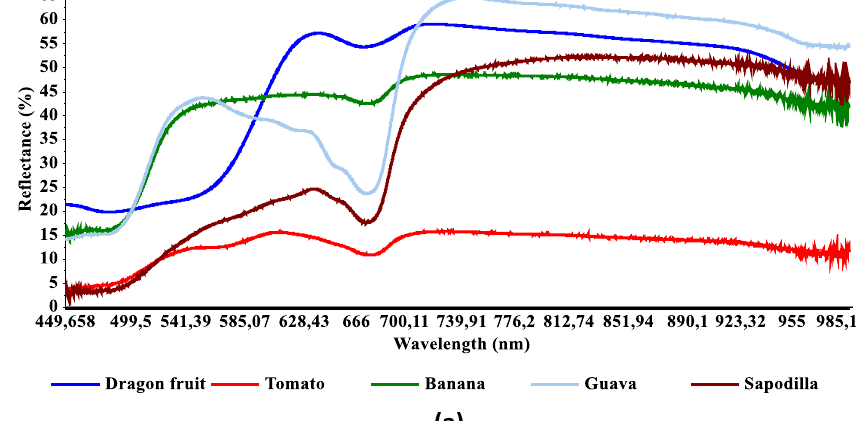
Figure 2 is re fl ectance spectra of dragon fruit, tomato,